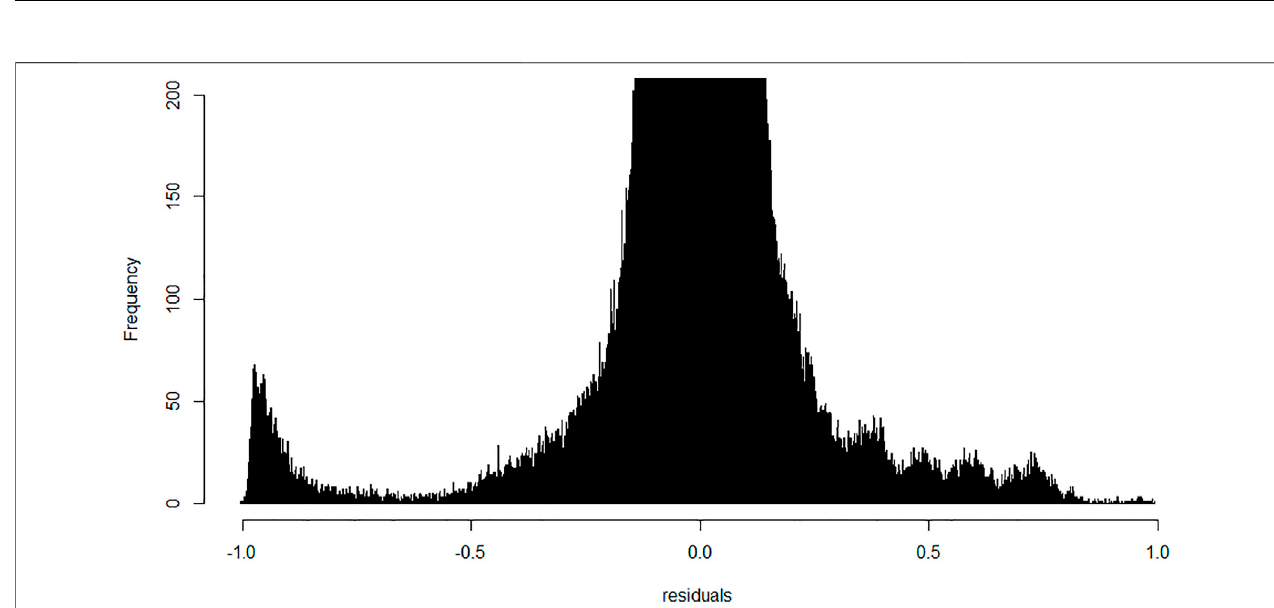
FIGURE 6 | Frequency of probes generated residuals after application of the fi tted linear model; bin width is 0.001. Y-range is limited from 0 – 200 to allow visualization of important minority groups. Most of the probes centered around zero with a small peak in the furthest negative region indicative of a cluster of probes methylated in polymorphonuclears and lymphocytes but not in the original buffy coat.